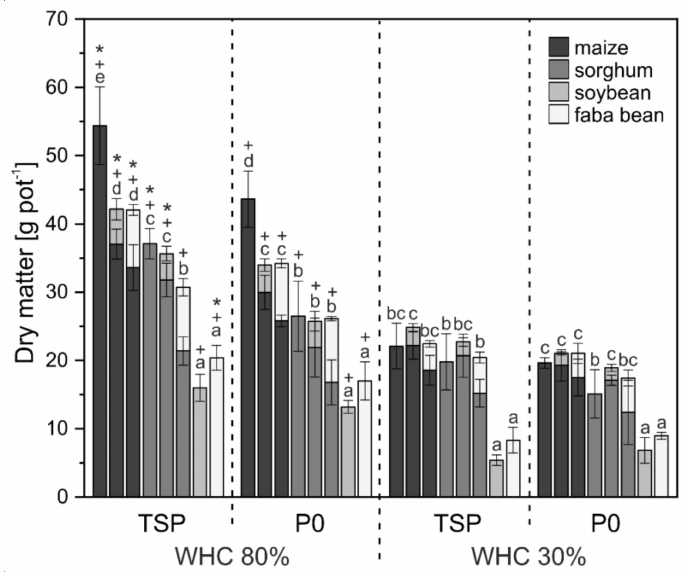
Figure 2. E ff ect of water supply and phosphorus supply on biomass (shoot dry matter) of the crops and mixtures in the Water-P-Trial (mean ± SD). Di ff erent letters indicate significant di ff erences between the crop variants at each water and P level, + indicates di ff erences between the water levels, * indicates di ff erences between the P levels (ANOVA and Duncan’s test, p ≤ 0.05). WHC = water holding capacity, TSP = triple-super P, P0 = control without